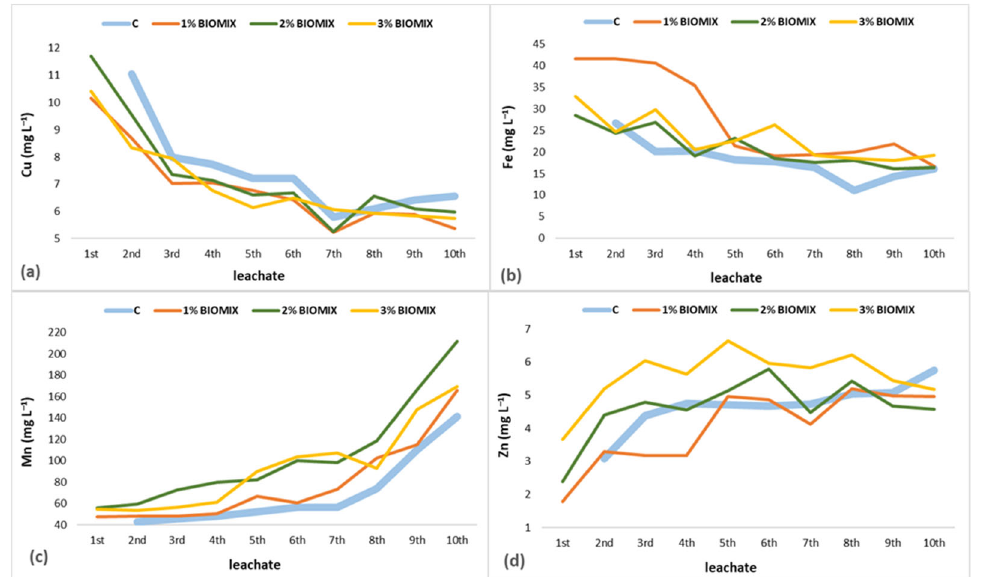
Figure 5. Changes of: ( a ) Cu (mg L − 1 ) concentrations, ( b ) Fe (mg L − 1 ) concentrations, ( c ) Mn (mg L − 1 ) concentrations and ( d ) Zn (mg L − 1 ) concentrations in the leachates of the 10 irrigation applications of the four treatments. Each value is the mean of three replicates.